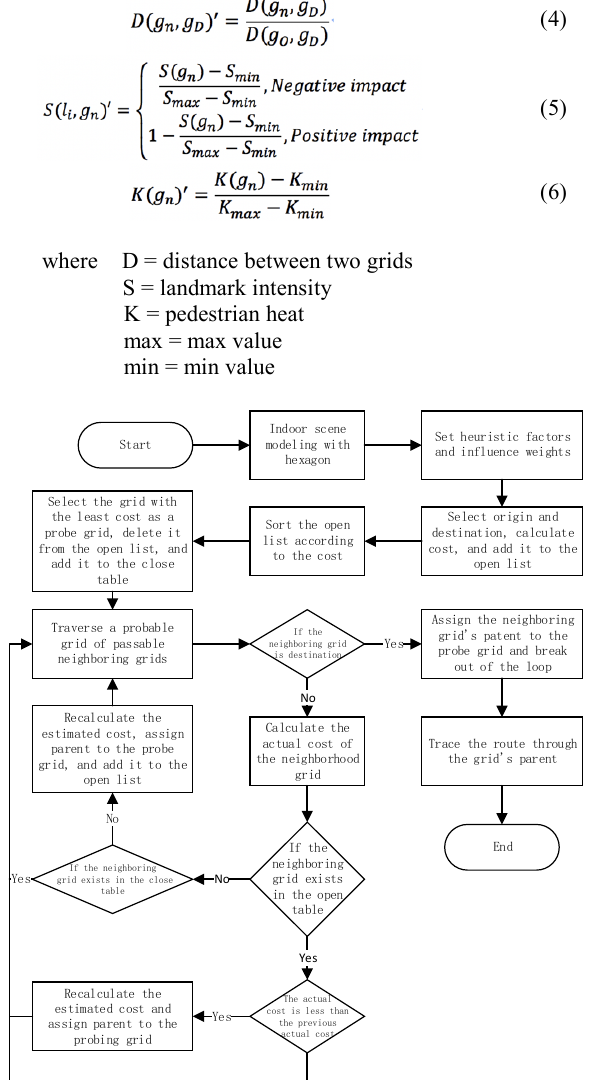
Figure 4. Flow chart of route planning based on A*